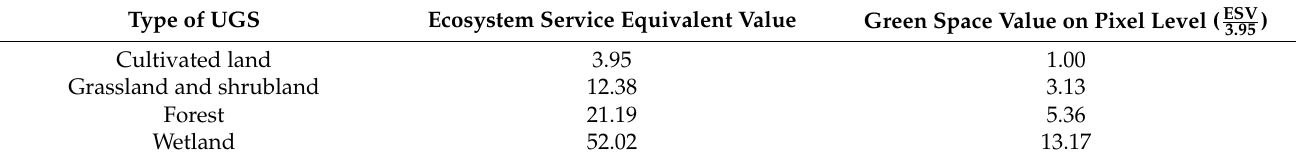
Table 1. Pixel values of different types of green